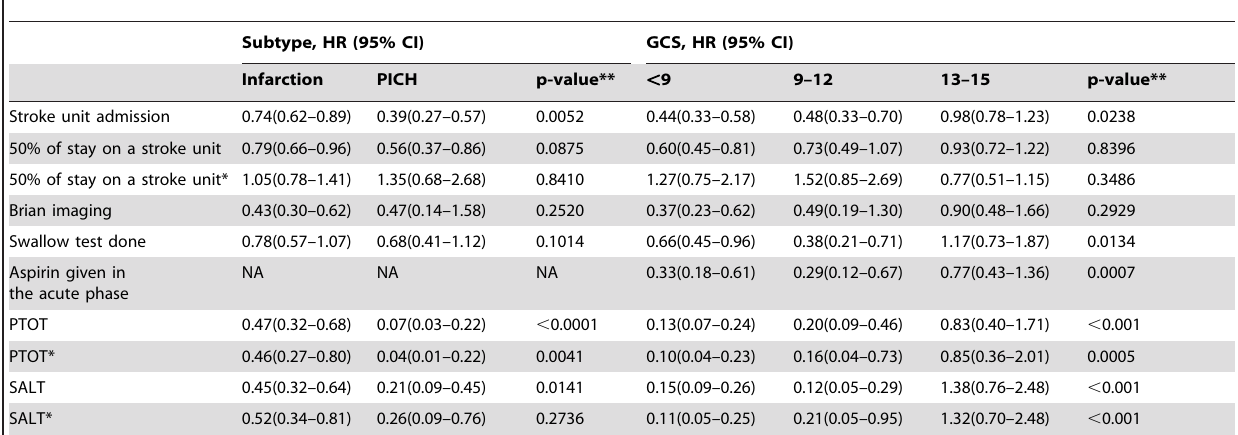
Table 5. Relative hazard of death following the receipt of acute care interventions by stroke subtype and